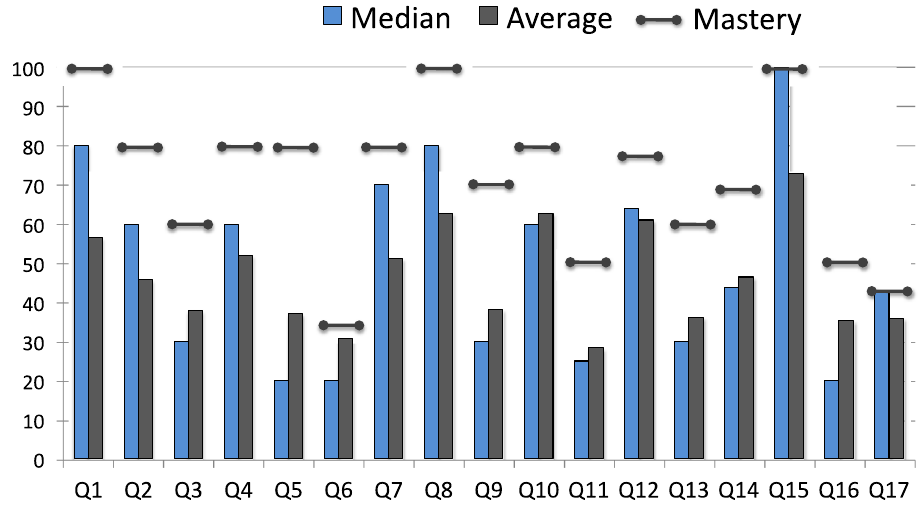
FIG. 6 (color online). Median, mean, and mastery performances on each question on the final version of the CUE for N ¼ 103 students. ‘‘Mastery’’ level represents the upper 70th percentile on each question; that is, 30% of students scored at or above this level, and 70% scored